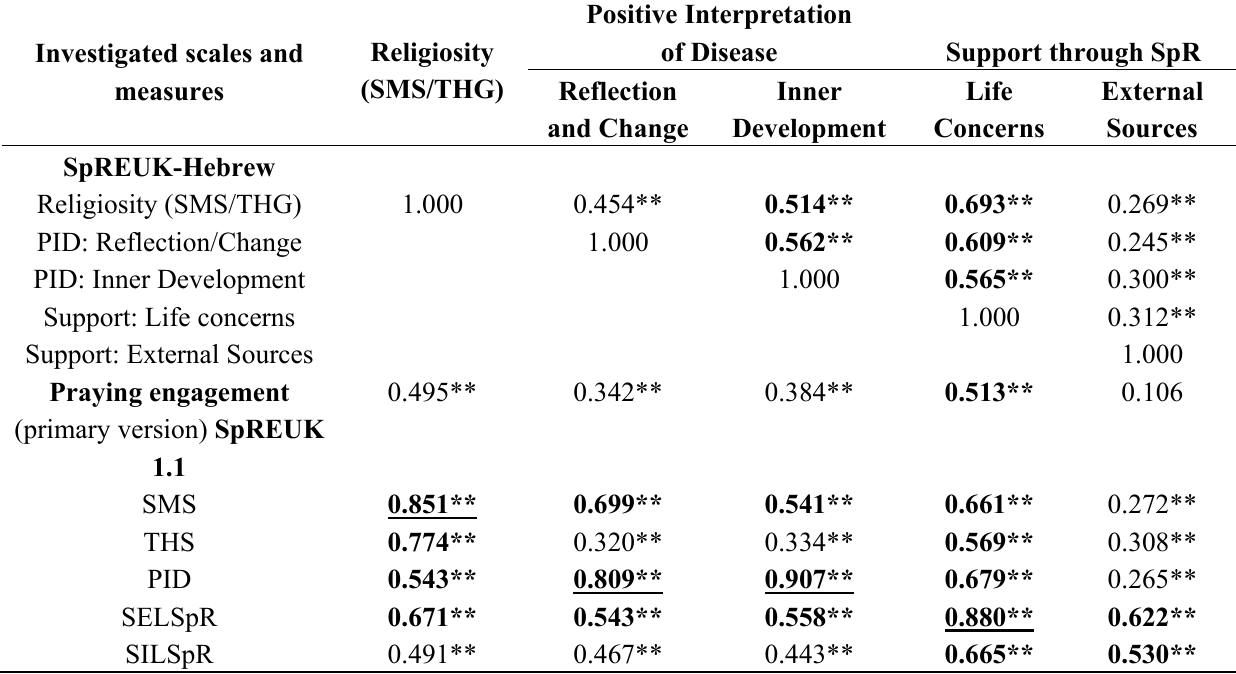
Table 4. Correlation between SpREUK-Hebrew sub-scales, primary SpREUK sub-scales and engagement in prayer.